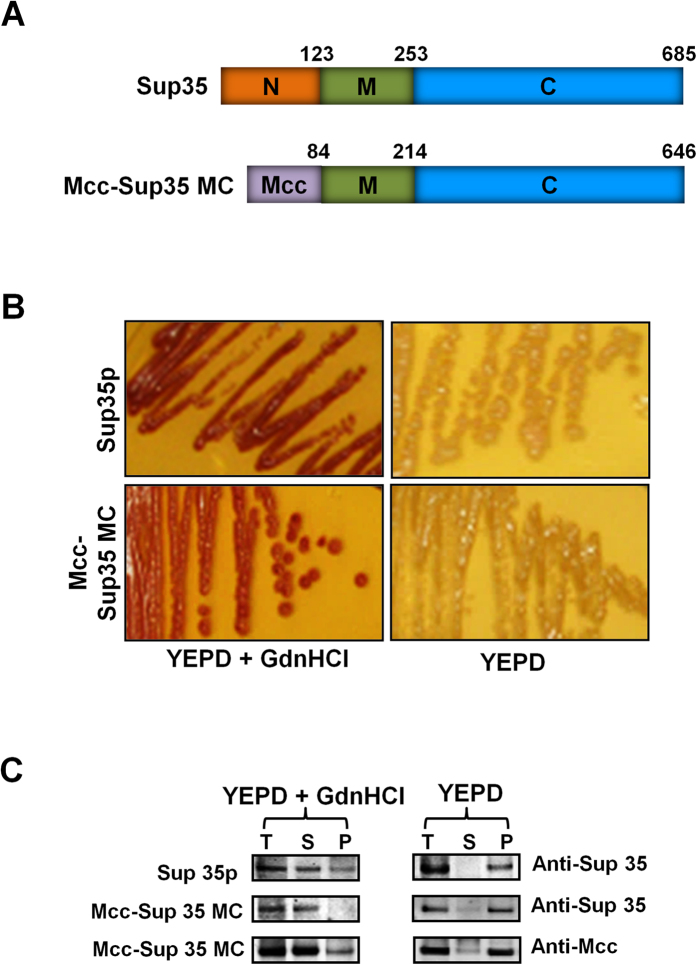
Mcc confers prion behaviors to Sup35 in a prion reporter assay in yeast.(A) Schematic representation of full length Sup35p containing the N, M and C domains and Mcc-Sup35MC fusion protein containing the full-length mature Mcc sequence (1–84) instead of its endogenous N region prion-forming domain (1–123 amino acids). (B) The color based assay that measures distinct heritable phenotypes of Sup35p and Mcc-Sup35MC fusion protein are shown after cells expressing Sup35p (as a positive control) and Mcc-Sup35MC fusion protein were plated onto YEPD and YEPD plates supplemented with 3 mM GdnHCl. (C) The sedimentation analysis of total cell extracts of cells expressing Sup35p and Mcc-Sup35MC grown on either YEPD alone or on YEPD supplemented with 3 mM GdnHCl. Total cell extracts (T) were centrifuged at 40,000 rpm for 30 min, resulting in supernatant (S) and pellet (P) that were separated on SDS-PAGE, immunoblotted, and probed with anti-Mcc and anti-Sup35p antibodies.